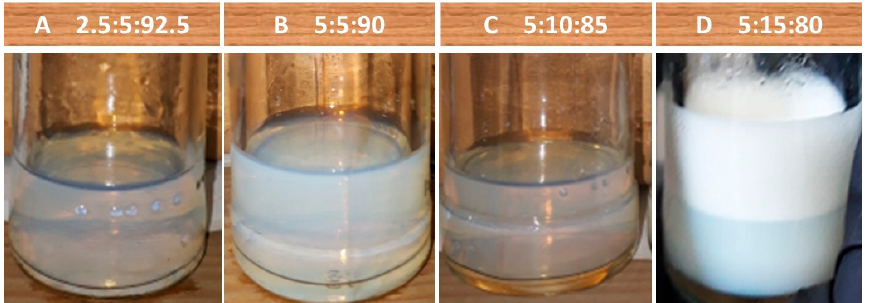
Figure 4. Emulsions of the Cedrela odorata essential oil in terms of the essential oil:surfactant mix- ture:water ratio: ( A ) 2.5:5:92.5; ( B ) 5:5:90; ( C ) 5:10:85; and ( D ) 5:15:80. Surfactant mixture (Tween 80– Span 80) of HLB = 10.46.